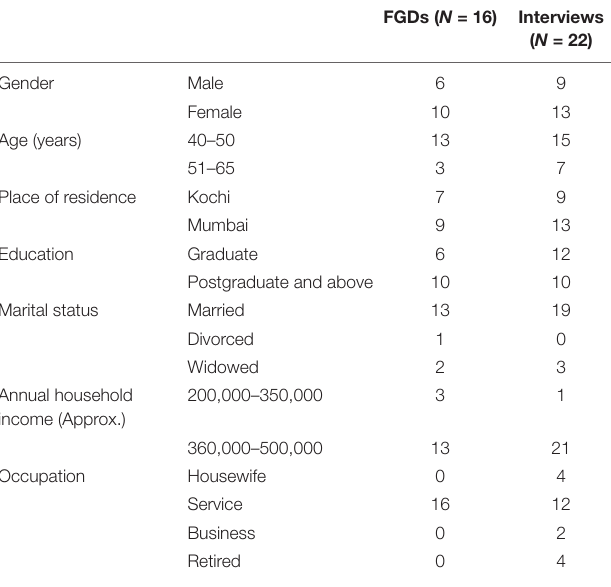
TABLE 3 | Socio-demographic characteristics of the sample (Phase I and Phase